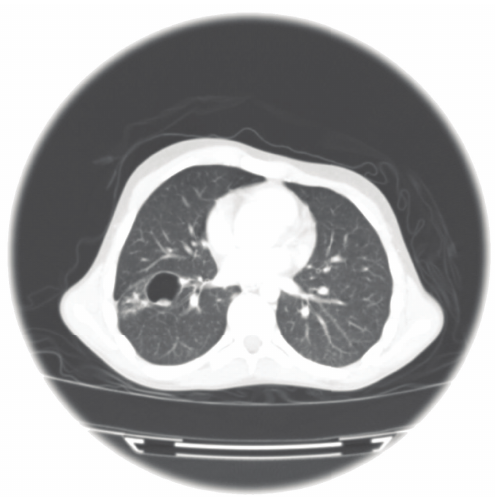
Figure 1: Pulmonary aspergillosis.